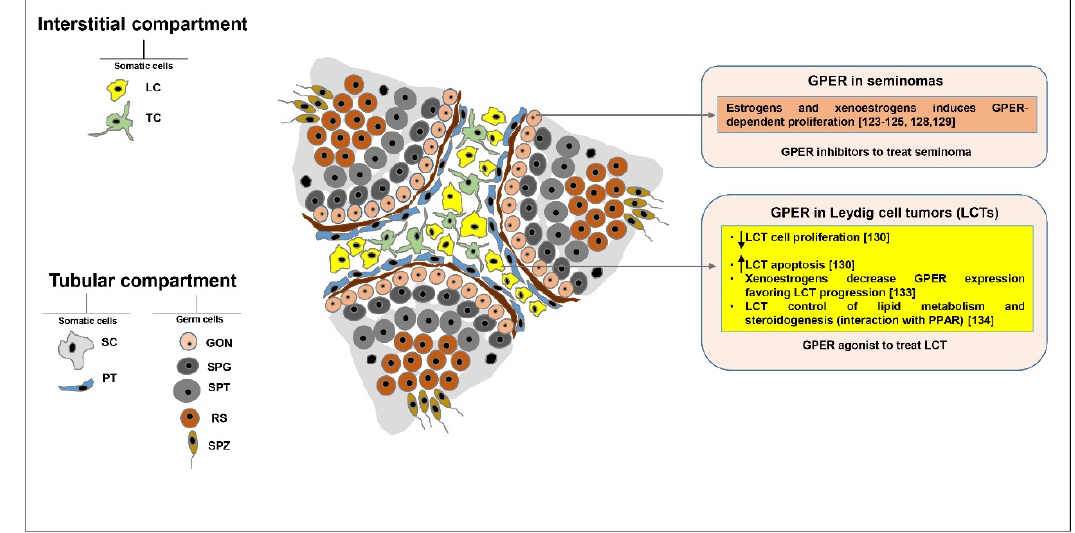
Figure 2. GPER role in testicular tumorigenesis. In this figure are summarized the knowledge ofGPER role in seminomas and Leydig cell tumors [LCTs]. LC: Leydig cells; TC: telocytes; SC: Sertoli cells; PT: peritubular cells; GON: gonocytes; SPG: spermatogonia; SPT: spermatocytes; RS: round spermatids; SPZ: spermatozoa.